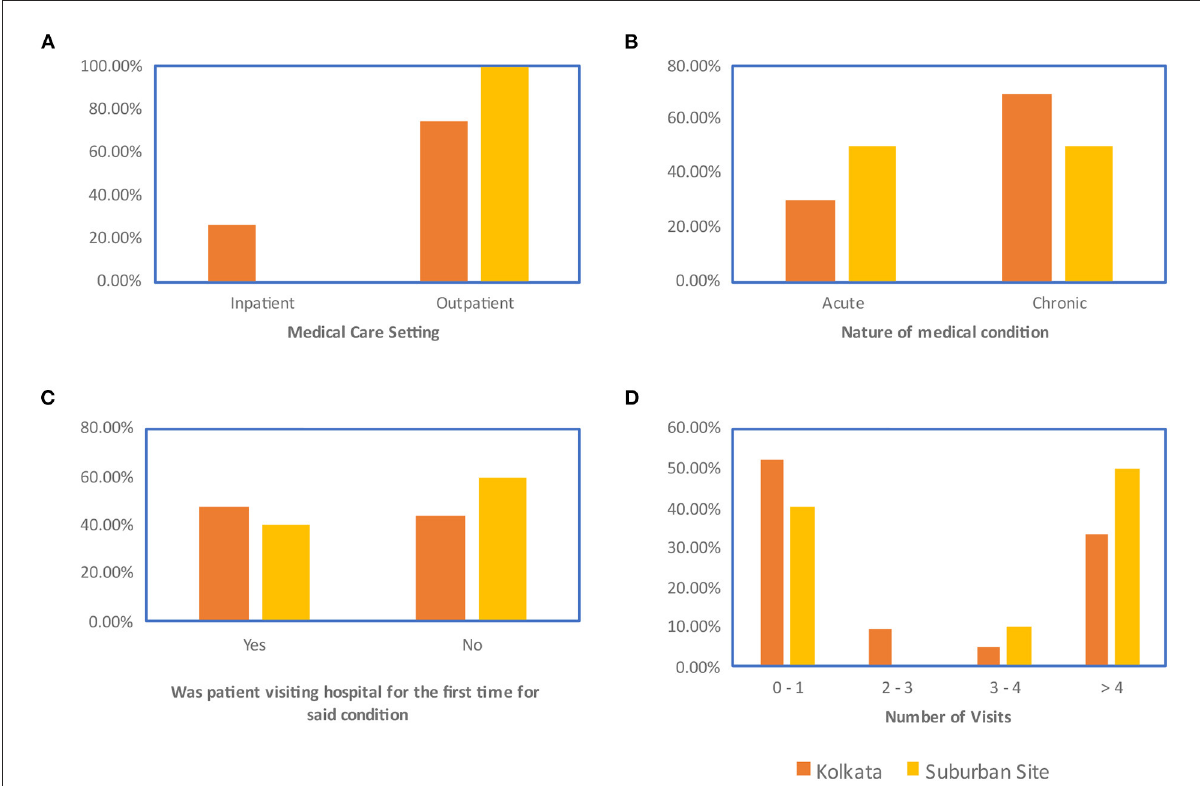
FIGURE4 Nature of patients’ medical visit at the time of interviewing: (A) Medical care setting (B) Nature of the medical condition (C) Whether the visit represented a first-time visit for a particular ailment (D) Number of hospital visits to address the particular